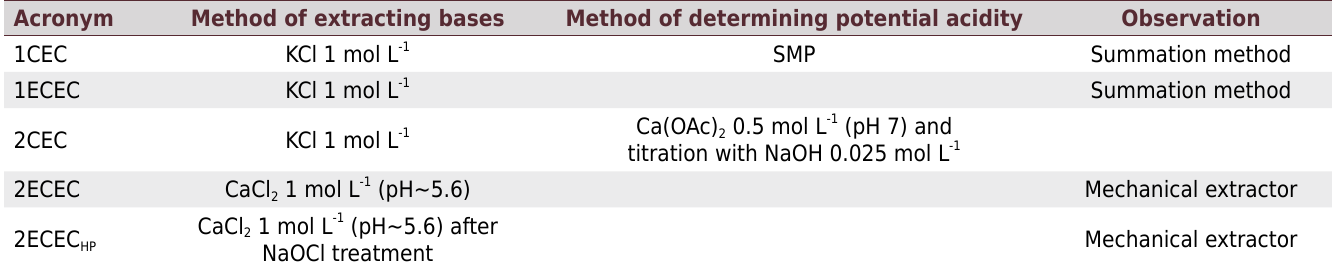
Table 1. Acronyms used to identify the different effective (ECEC) and cation (CEC) exchange capacities determined with different methods to extract the exchangeable bases, acidity and potential acidity and equipment Acronym Method of extracting